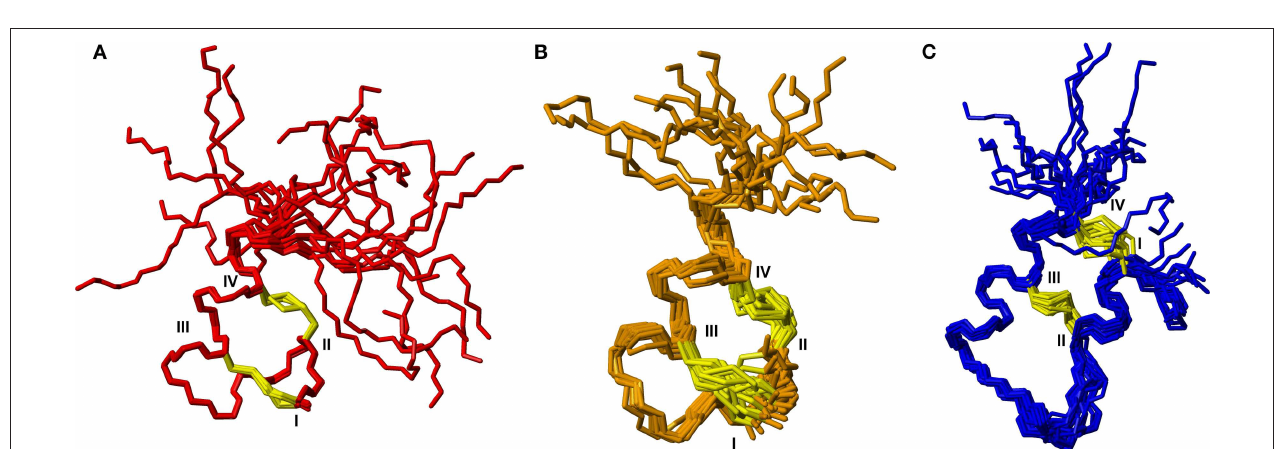
FIGURE 4 | Backbone superposition of the 20 best structures calculated based on NMR spectroscopy data for (A) analog 3 , (B) analog 9, and (C) analog 5 . Cystine side chains are shown in yellow. Cystine positions in the sequences are indicated by roman numerals.